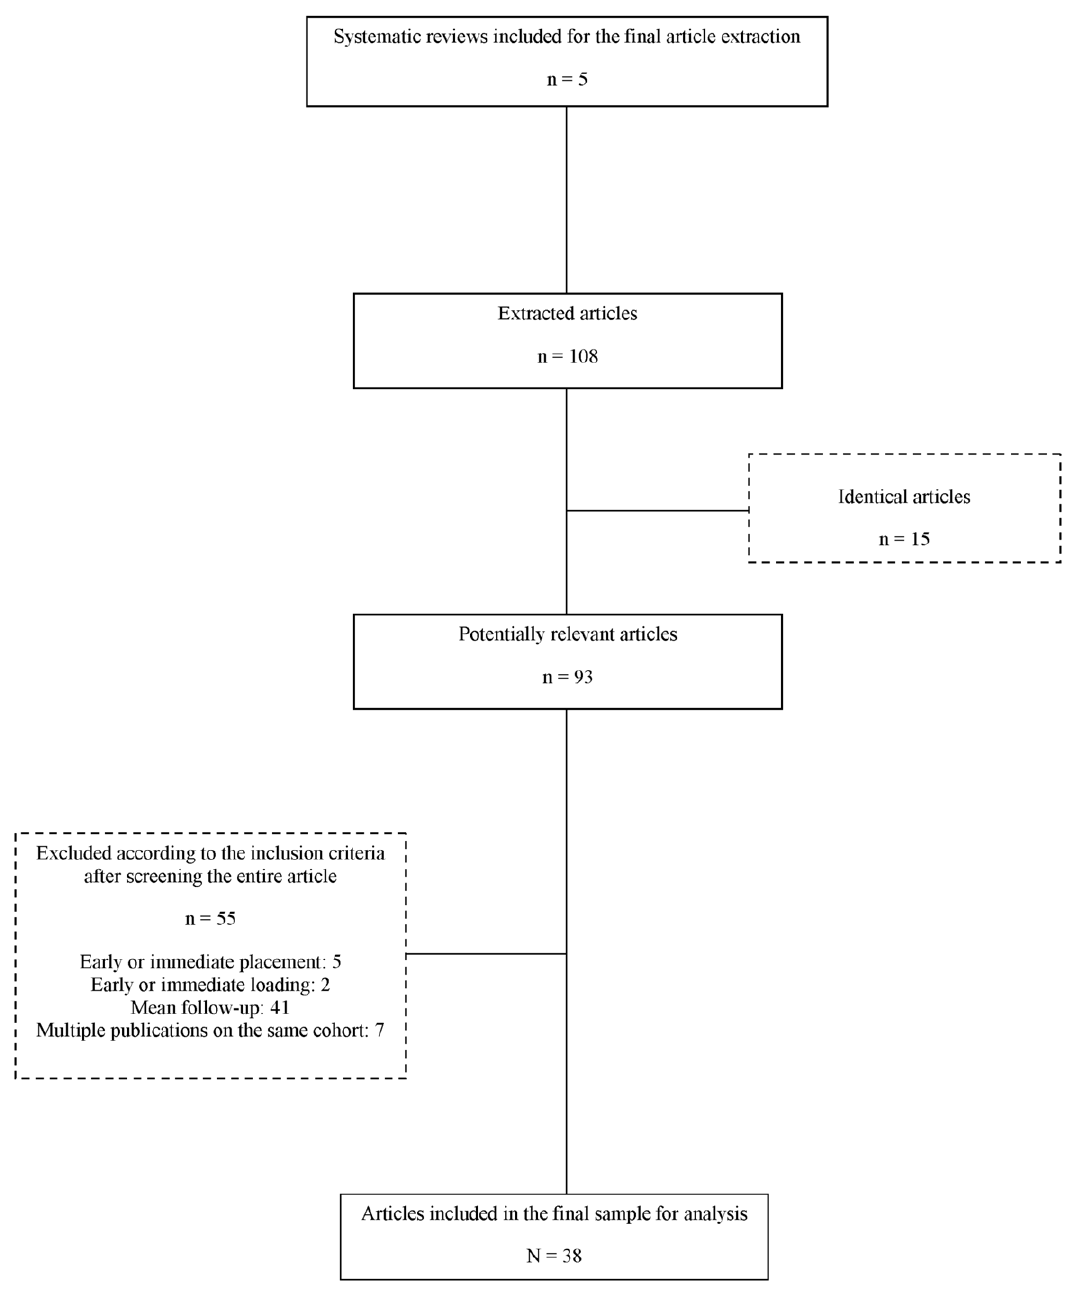
Figure 2. Flowchart of the primary article selection.